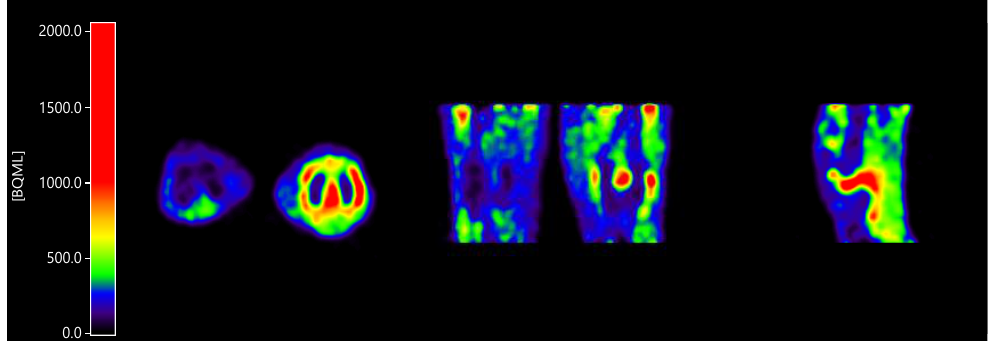
Figure 1. Enhanced [ 11 C]DPA-713 (N,N-diethyl-2-[2-(4-methoxyphenyl)-5,7-dimethylpyrazolo [1,5- a]pyrimidin-3-yl]acetamide) uptake in a clinically inflamed knee joint compared to a clinically non- affected knee joint, in axial orientation (inflamed joint right), coronal orientation (inflamed joint right), and sagittal orientation (only inflamed joint).